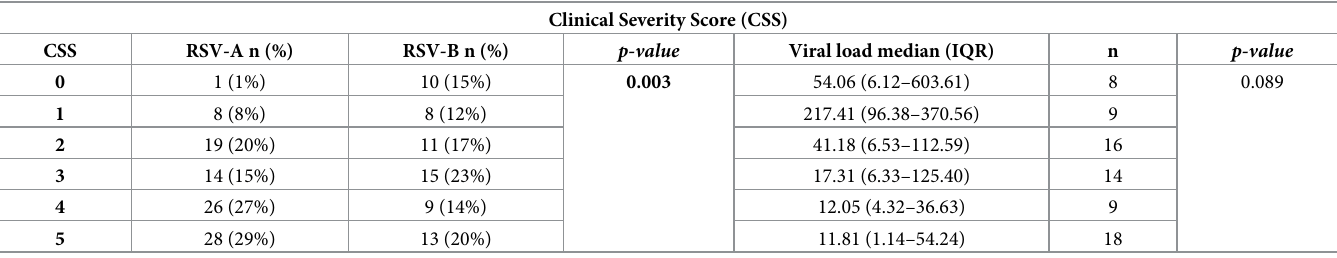
Table 3. Clinical Severity Score (CSS): Scores varied from 0 to